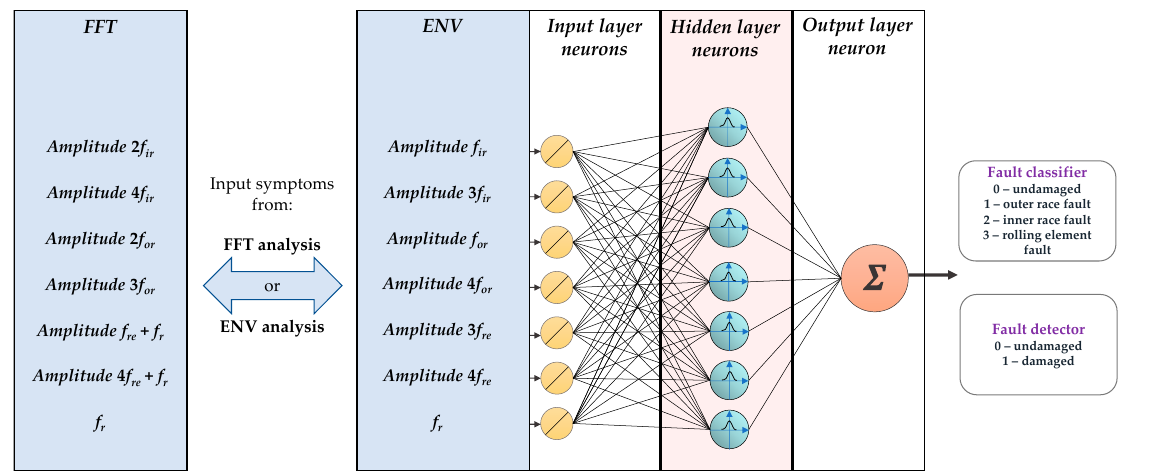
Figure 10. Schematic diagram of a fault detector or fault classifier based on RBF network with different input signals: after FFT or ENV analysis.